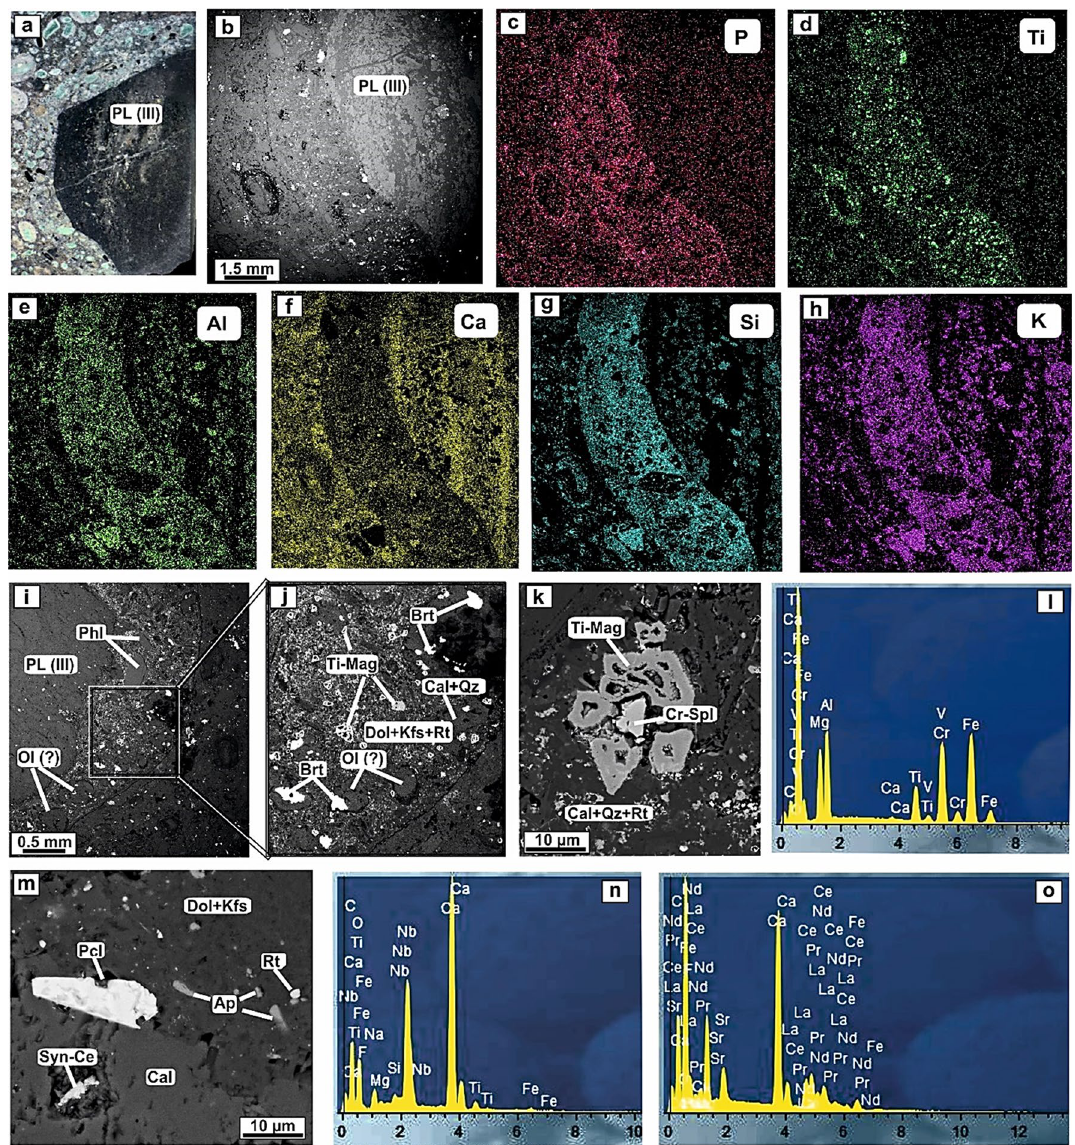
Figure 4. Photomicrograph ( a ) and BSE image of type III pelletal lapilli (PL-III) ( b ), as well as the composition of its rim according to SEM elemental mapping showing the distribution of P, Ti, Al, Ca, Si and K ( c-h ). BSE images ( i–k,m ) and SEM-WDS spectra of minerals: Cr-spinel (Cr-Spl) ( l ), pyrochlore (Pcl) ( n ) and synchysite- (Ce) (Syn-Ce) ( o ) making up the rim mineral assemblage of pelletal lapilli-III. Other phases routinely identified include olivine (?), phlogopite, apatite and Cr-spinel-Ti-magnetite primary grains located in a K-feldspar- dolomite matrix with secondary calcite, quartz, rutile, barite and